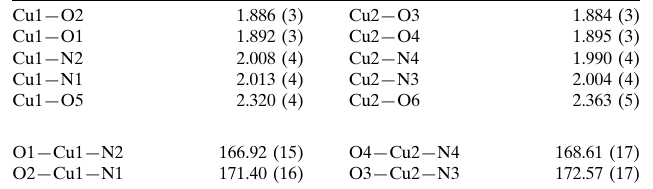
Selected geometric parameters (A˚ , (cid:3) ).